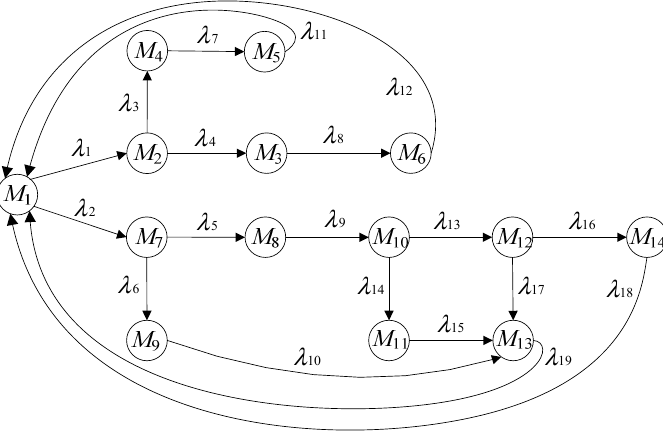
Figure 6. MC is isomorphic with the SPN model.